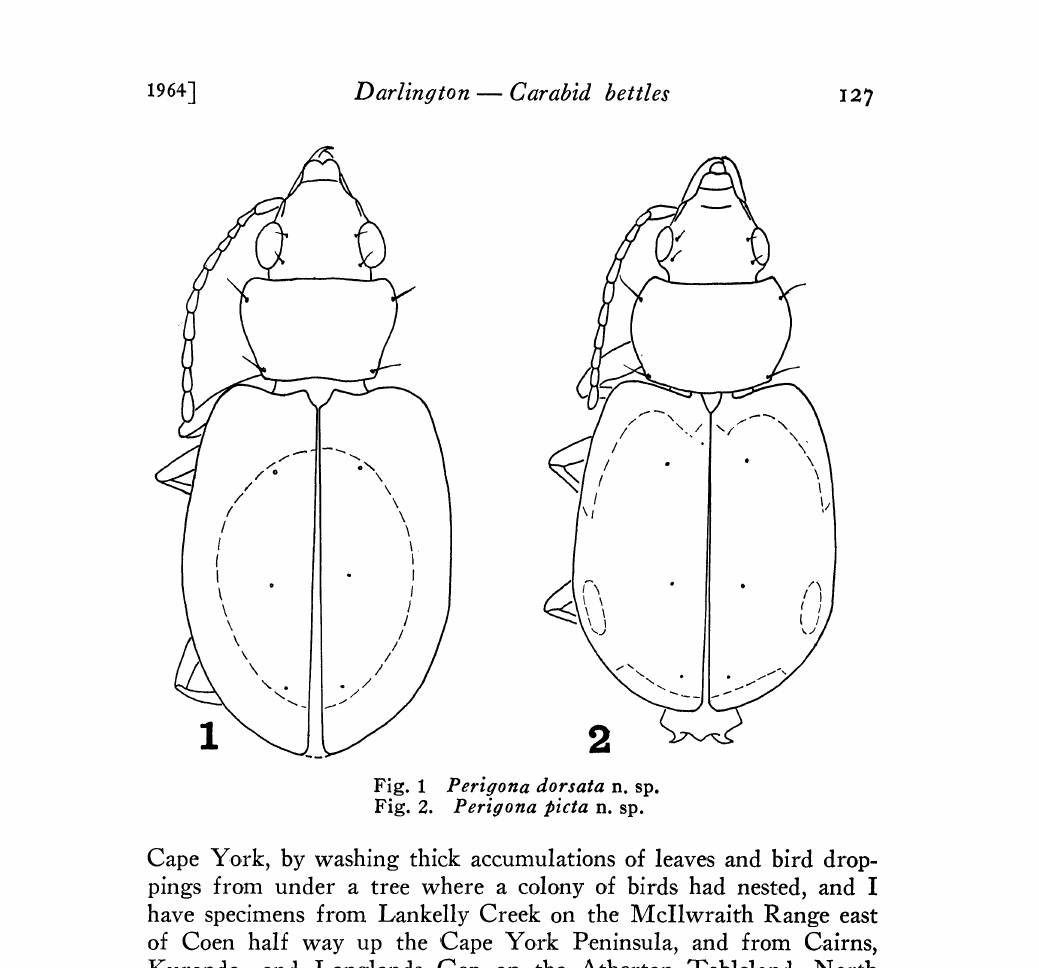
Form as figured (Fig. ), almos.t as in nigriceps but slightly less broad; head black (except labrum and mandibles testaceous), pro- notum dark reddish brown, elytra reddish testaceous with median dorsal cloud brown (suture pale) shining, slightly iridescent, reticu- late microsculpture lightly impressed, c. isodiametric .on head,